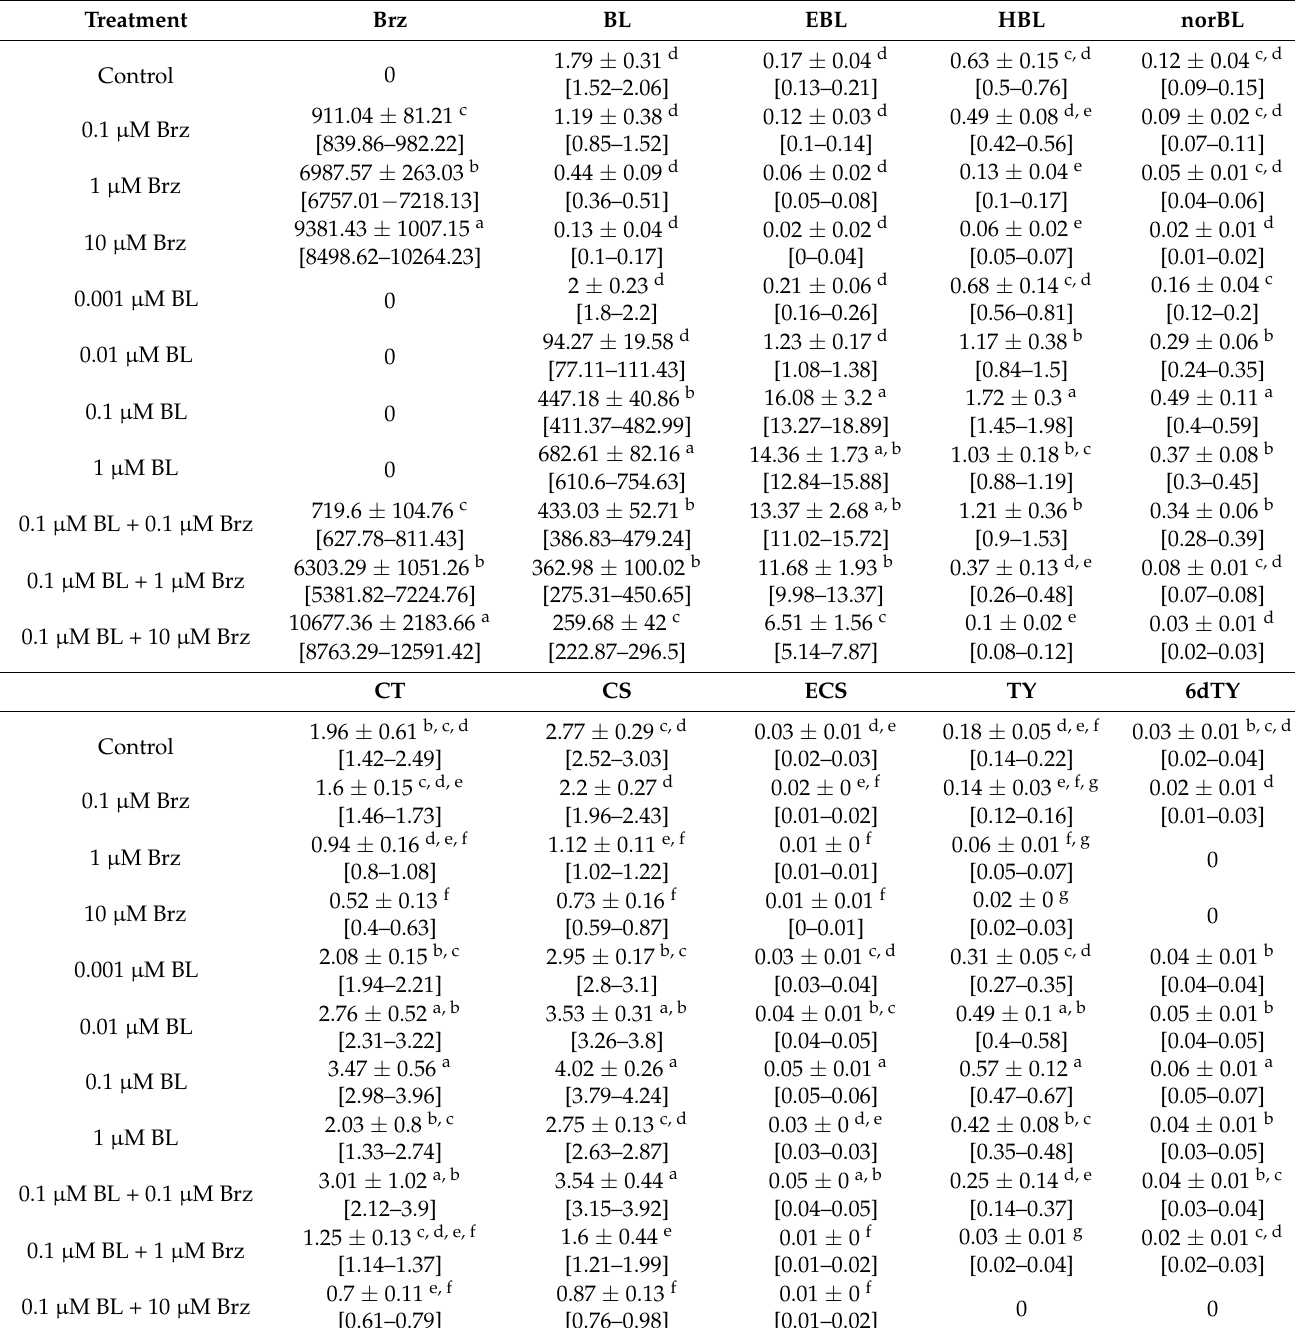
Table 1. The endogenous level (ng/g fresh weight) of Brz and BRs in W. arrhiza treated with Brz and/or BL after 7 days of cultivation. Data present the mean ( n = 5) ± standard deviation. The range in square brackets corresponds to the 95% confidence interval of the mean. Means with the same letters are not significantly different ( p ≥ 0.05) according to Tukey’s post hoc